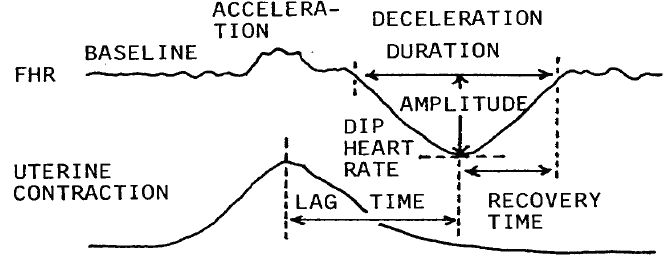
Figure 2. Quantified analysis of FHR changes for computerized experts’